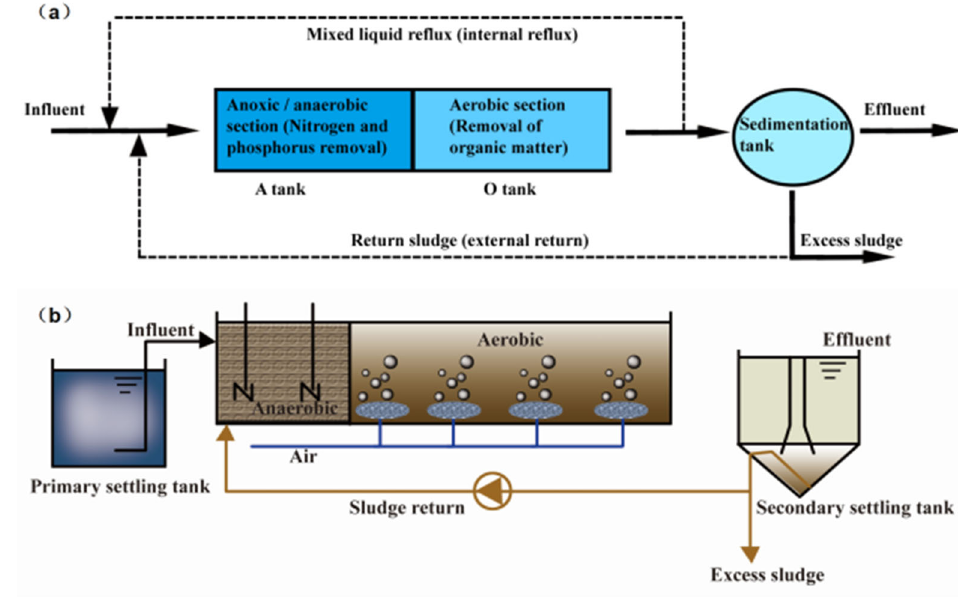
Figure 1. A/O process flow ( a ) and schematic diagram ( b ).